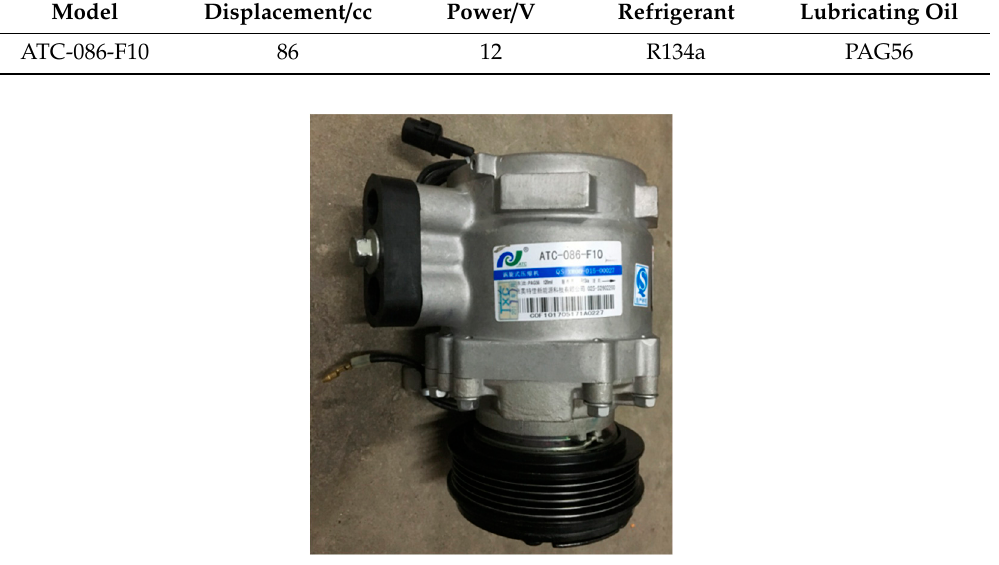
Figure 5. The scroll compressor used in experiments. Table 1. The basic parameters of the compressors.